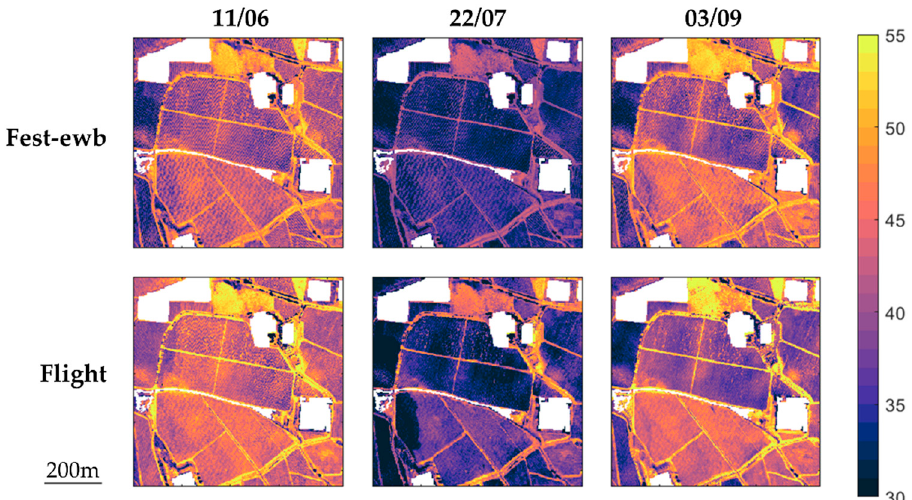
Figure 3. Comparison between FEST-EWB generated RET ( upper row ) and proximally sensed LST ( lower row ) for the three calibration dates.